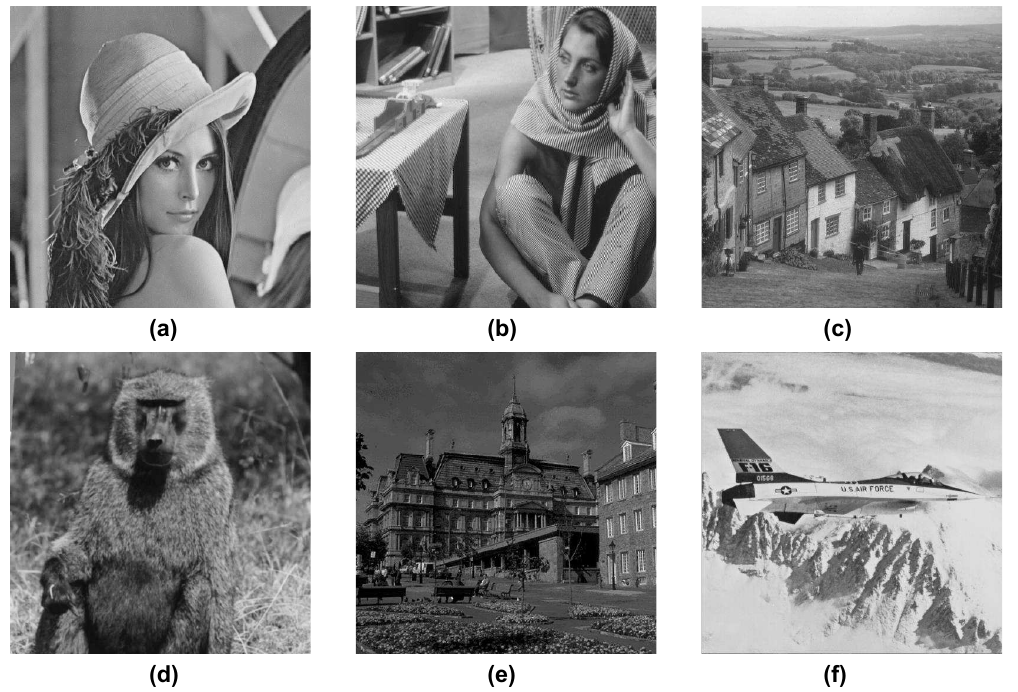
Figure 7. Six images to test feasibility of proposed method for memory